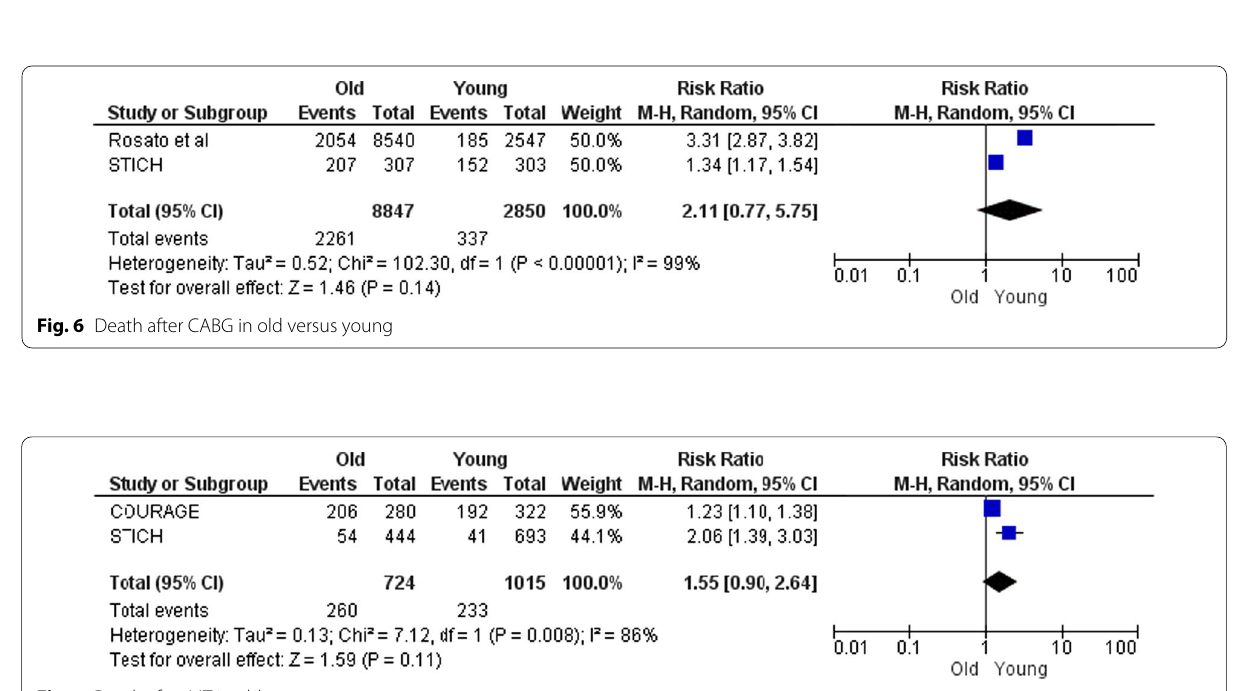
Fig. 7 Death after MT in old versus